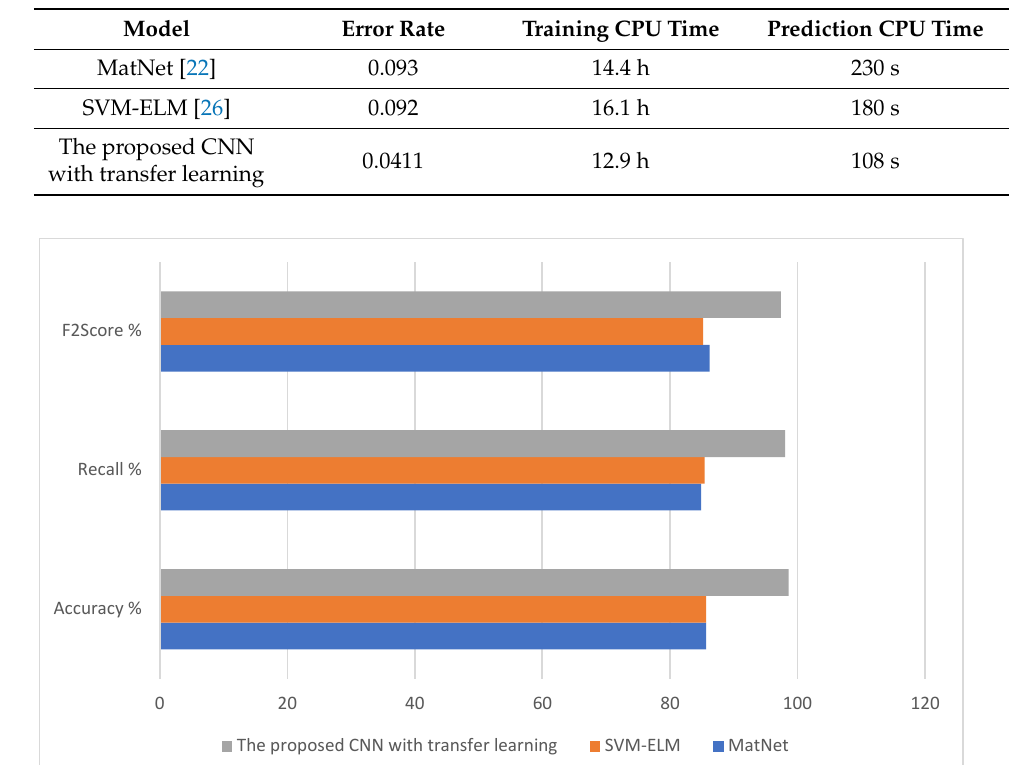
Figure 8. Predicted oxygen vacancy dimension using Ion volume with transfer learning. Table 10. Comparison results.